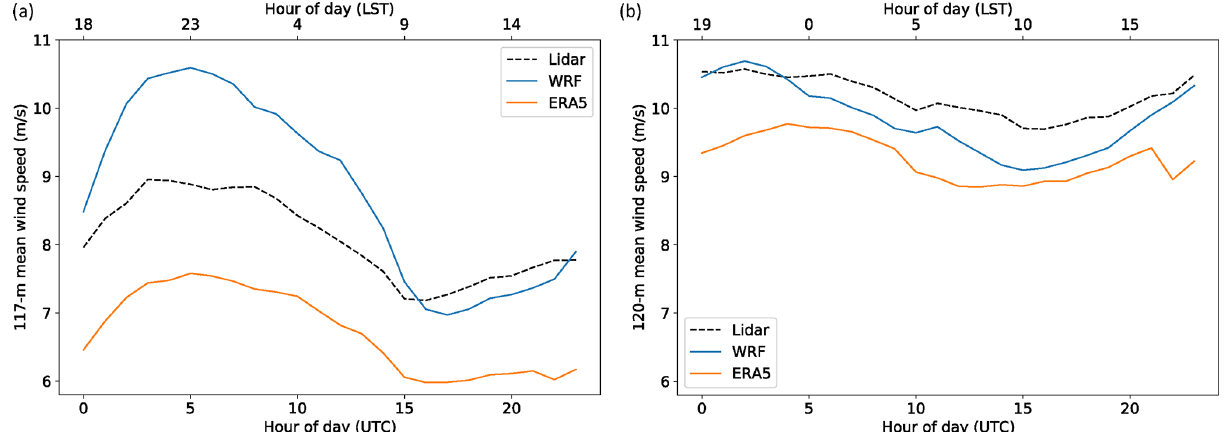
Figure 8. Average diurnal cycle of the ∼ 120m wind speed from lidar, WRF, and ERA-5 at (a) the SGP C1 site and (b) the location of the E05 lidar. Results from the E06 lidar are included in the Supplement.